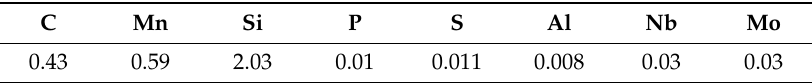
Table 1. Chemical composition (wt %) of used